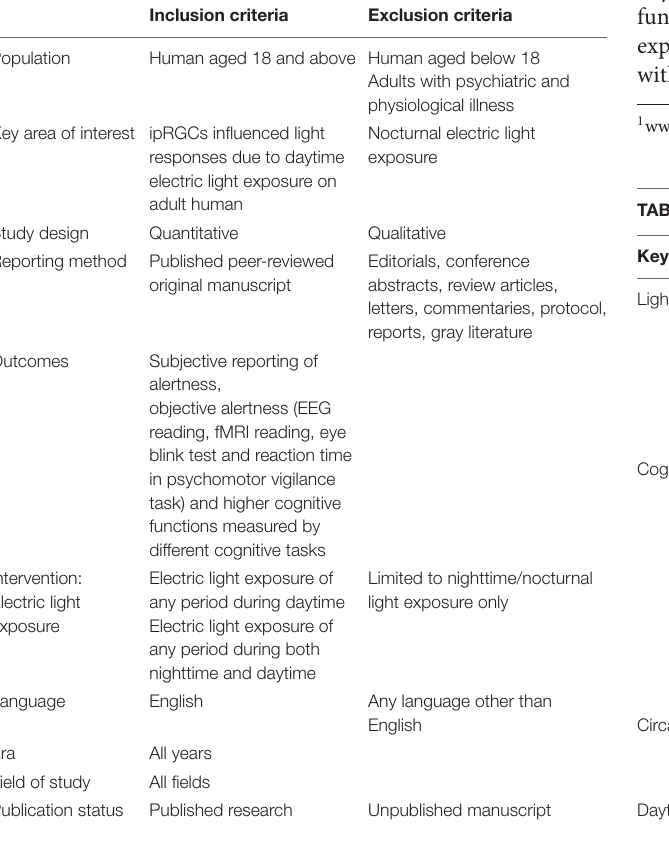
TABLE 3 | List of inclusion-exclusion